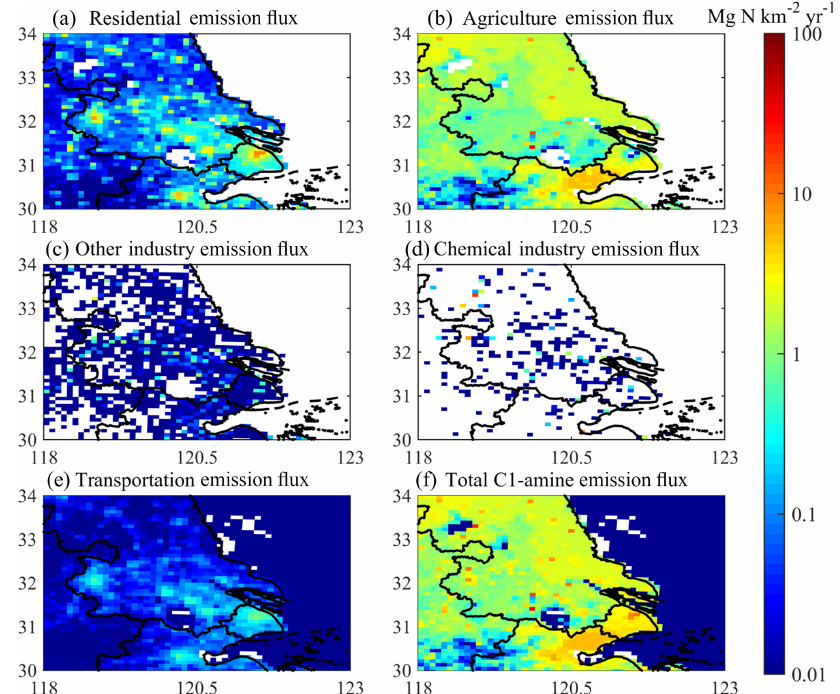
Figure 2. The horizontal emission flux distributions for C1-amine: (a) residential; (b) agriculture; (c) other industry; (d) chemical industry; (e) transportation; (f) total.